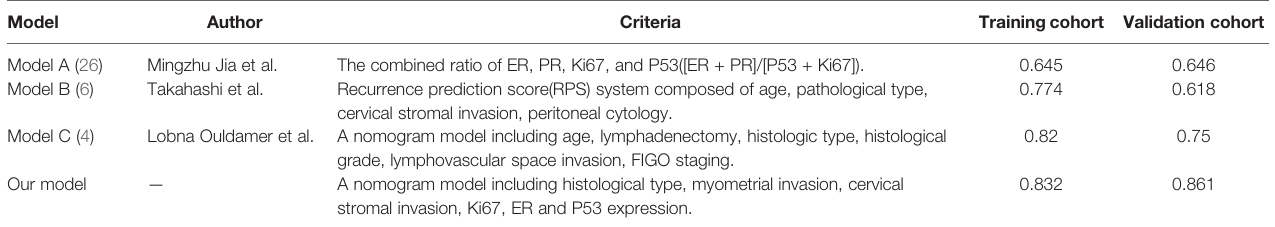
TABLE 5 | The discriminatory power (C-index) of different